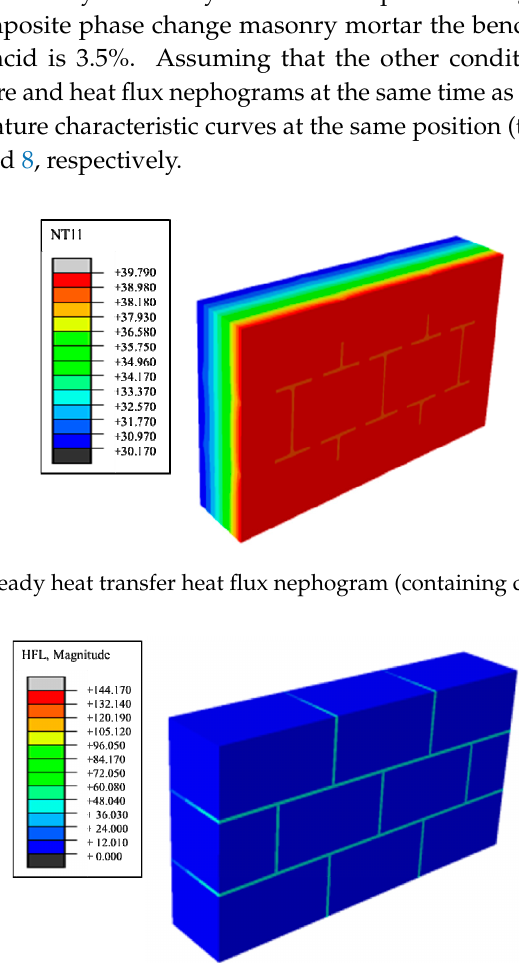
Figure 4. Heat flux nephograms of steady heat transfer.